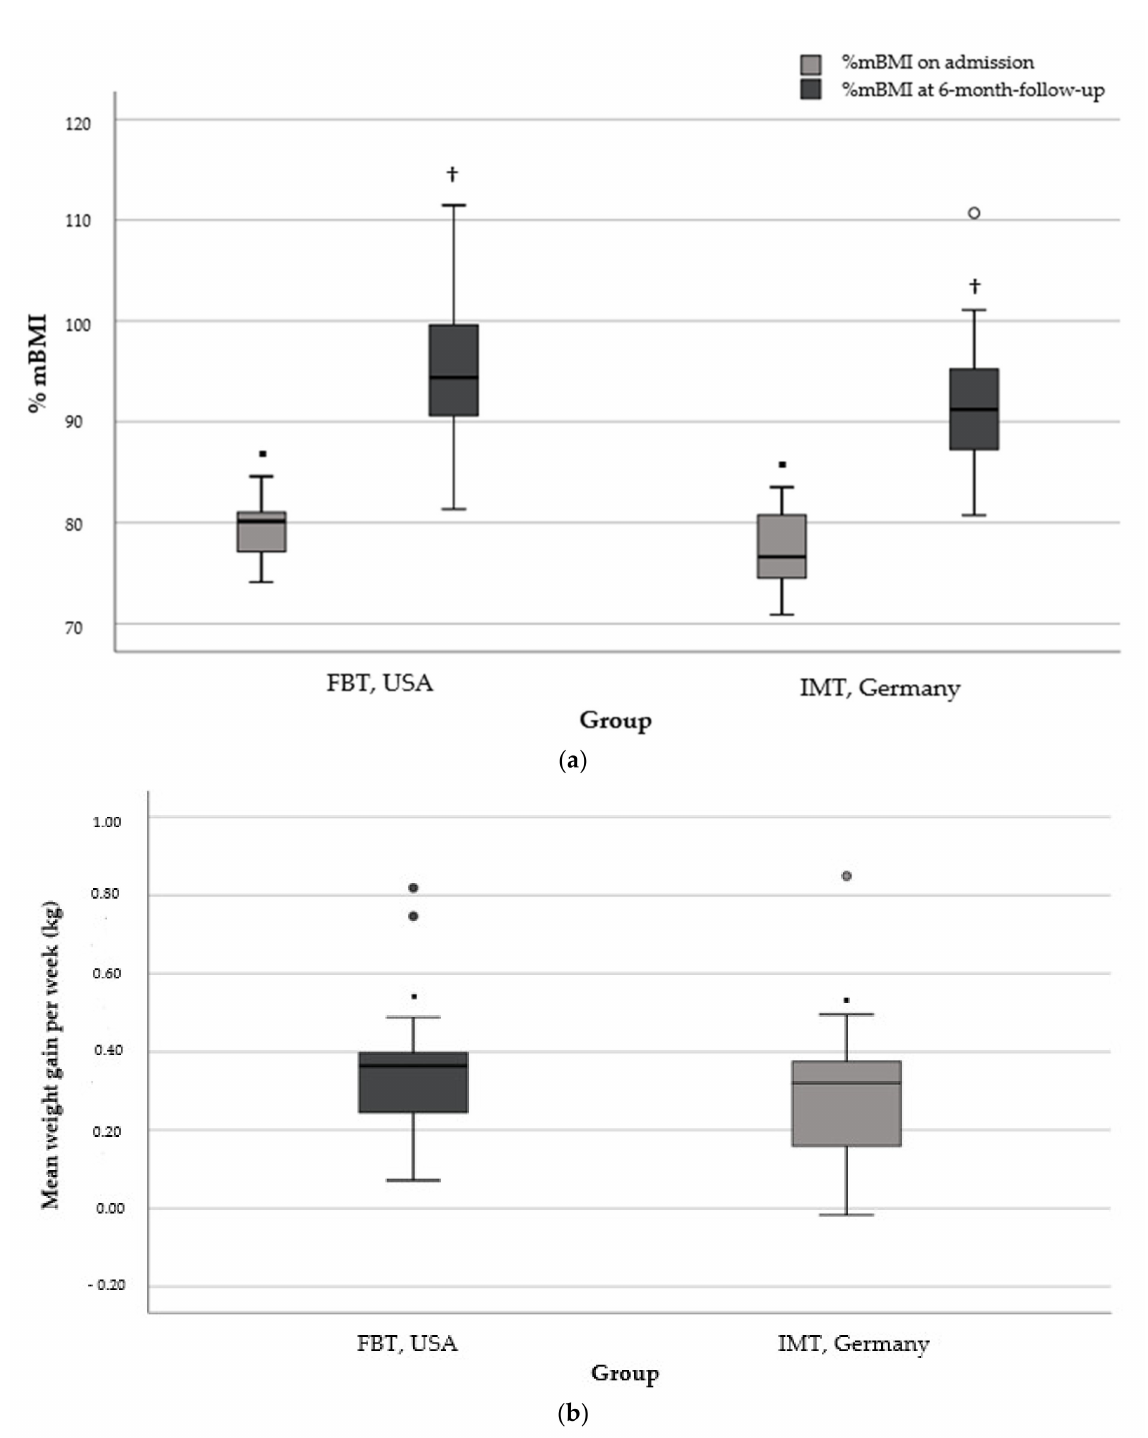
Figure 3. ( a ) %mBMI at baseline and 6-month follow-up in the FBT and IMT subgroup. (cid:4) , group difference of %mBMI on admission ( (cid:4) p = 0.081); † , group difference of %mBMI at 6-month follow-up ( † p = 0.131). ( b ) Mean weight gain per week in kilogram from baseline to 6-month follow-up in the FBT and IMT subgroups. (cid:4) , group difference of mean weight gain per week in kilogram ( (cid:4) p = 0.407). Note for both: FBT, family-based treatment with/without medical stabilization as needed; IMT, inpatient multimodal treatment followed by outpatient care; kg, kilogram; ◦ , statistical